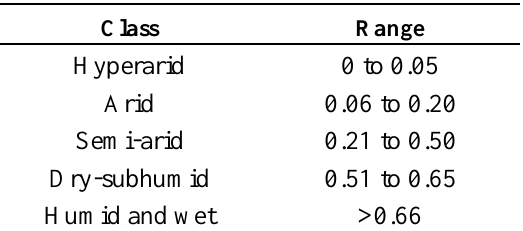
Table 1. Aridity-humidity Classification of the value of MAAI, the ratio of actual to potential evaporation (after [52]).